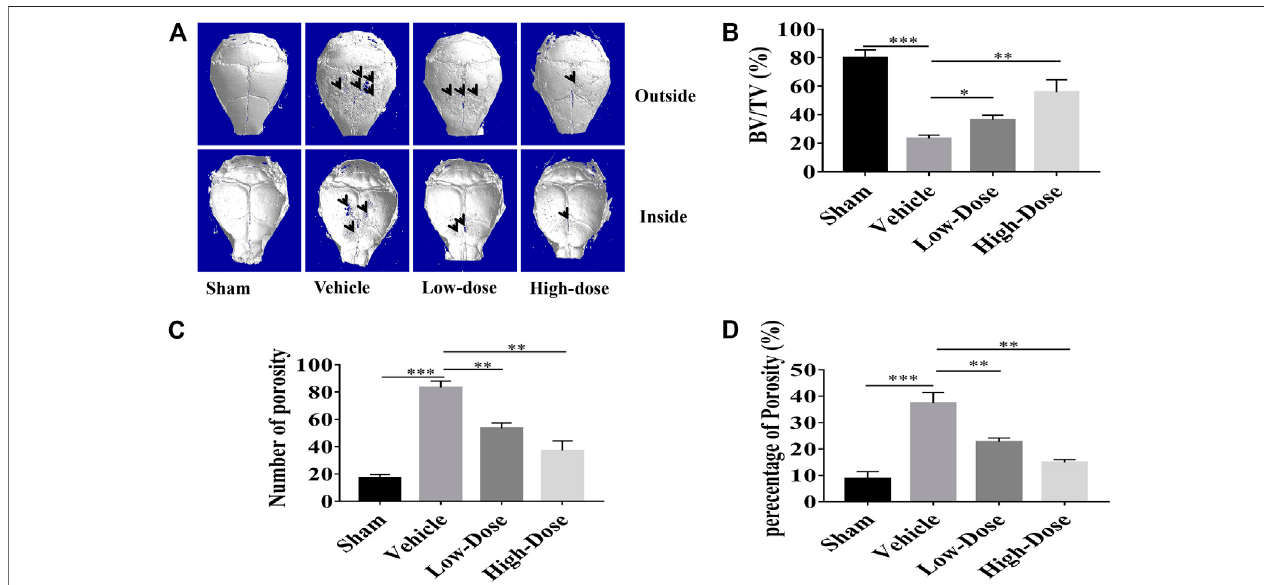
FIGURE 6 | CHR protected against titanium particles-induced osteolysis of mouse calvaria. (A) Representative micro-CT three dimensional reconstructed images ofcalvarialtissuefromSham,PBSvehicle,andCHRtreatmentgroups.Histomorphometricanalysisof (B) bonevolumetotissuevolume(BV/TV,%), (C) numberofbone porosity, and (D) the percentage of total bone porosity of treatment groups (* p < 0.05, ** p < 0.01, *** p < 0.001).